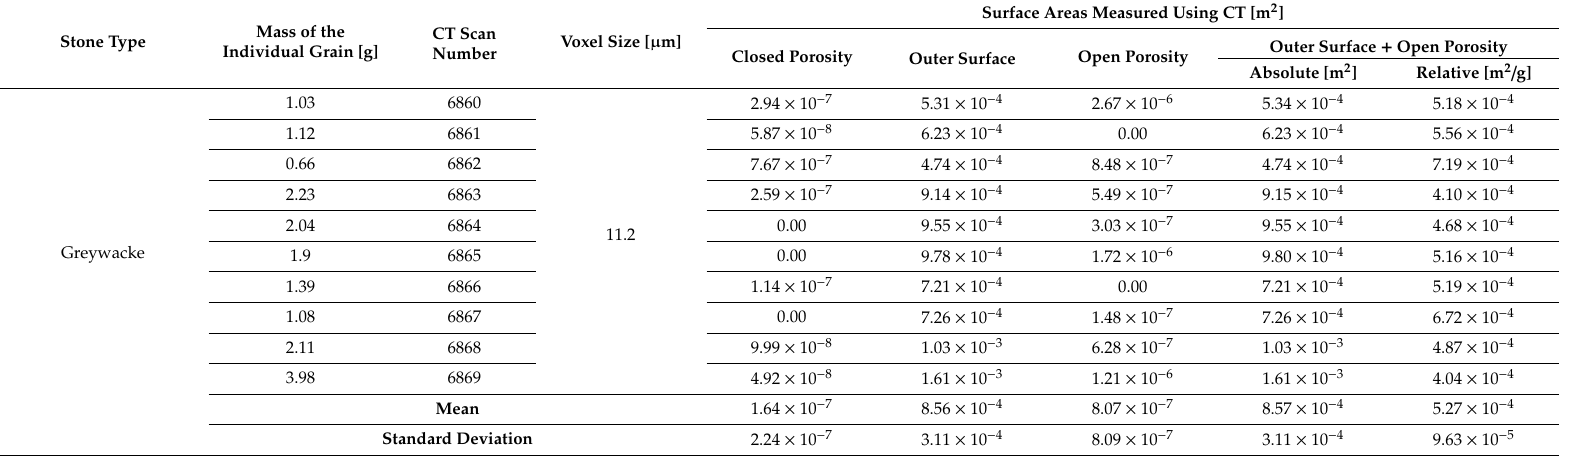
Table A2. Individual grain results from the cracking analysis of stone category GK2 (quarried stone; alkali sensitivity